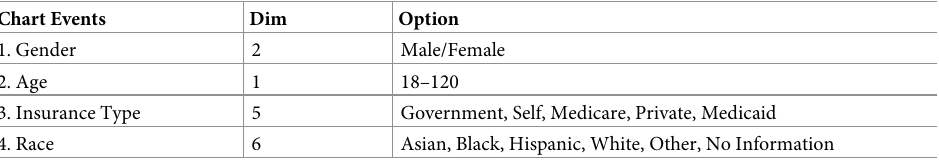
Table 2. Demographic features.